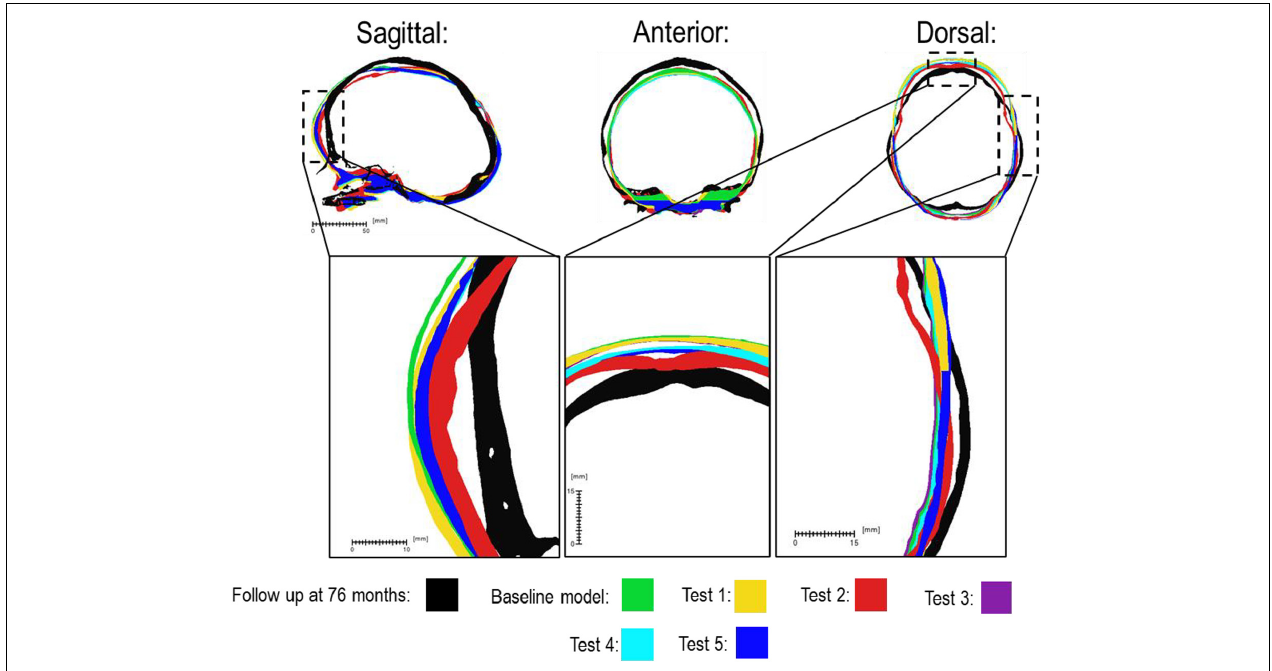
FIGURE 2 | Material property and bone formation rate sensitivity cross-sections vs. follow up at 76 months of age. Dashed boxes indicate enhanced regions of interest.